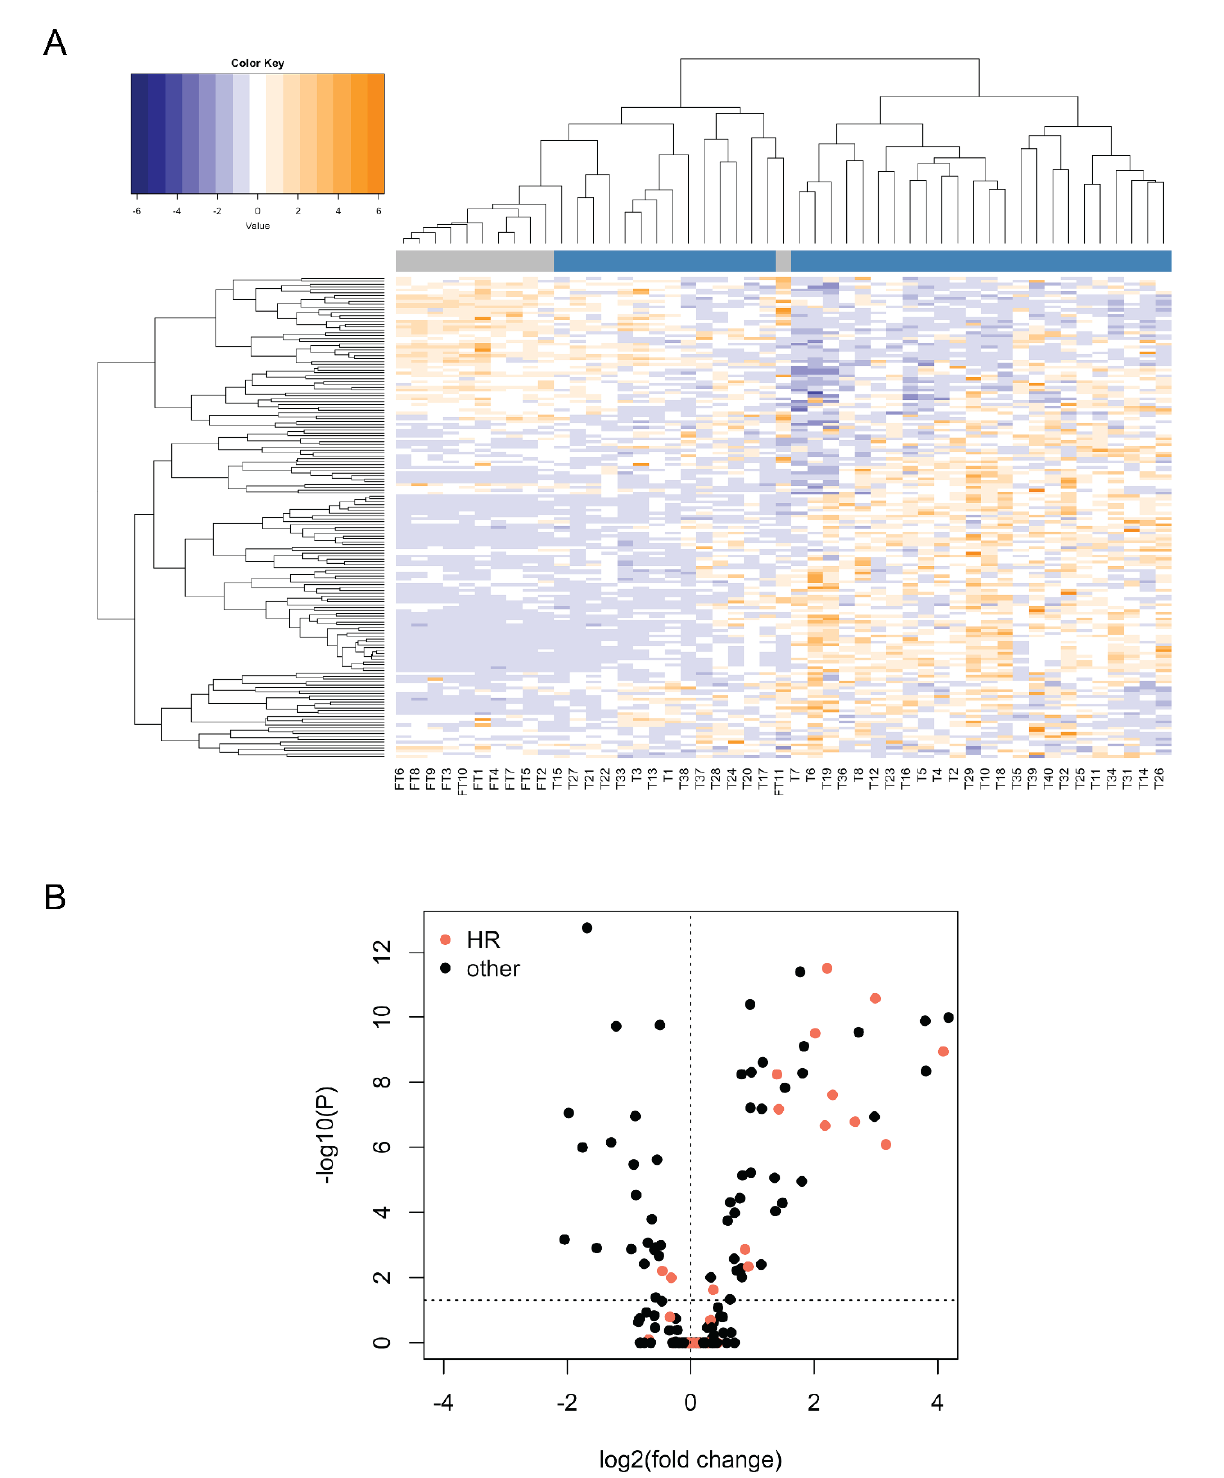
Table 1). Among the 47 genes showing significantly higher expression in tumors, 13 (~28%)